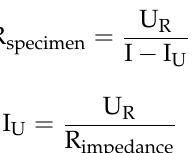
Figure 4. Experimental set-ups of the measurements of: ( a ) resistivity; and ( b ) heat